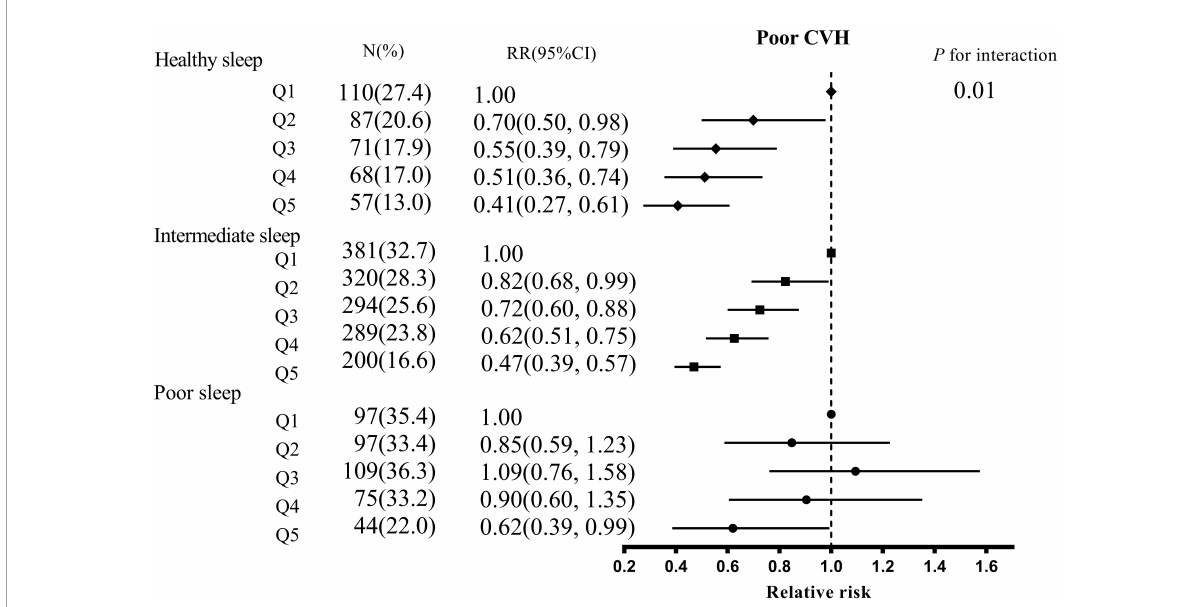
FIGURE1 The association between serum 25(OH)D concentrations and poor CVH stratified by overall sleep patterns. CVH, cardiovascular health; CI, confidence interval; Q, quintile. Adjusted for age, education, household income, residence, the season of blood collection, prepregnancy BMI, GWG rate, parity, depression, family history of diabetes, hypertension, and CVD, smoking, husband’s smoking, daily outdoor time, sun exposure, activities, dietary vitamin d intake habits (sea-fish, egg, milk, fungi, red meat, and white meat intake), vitamin D supplementation.